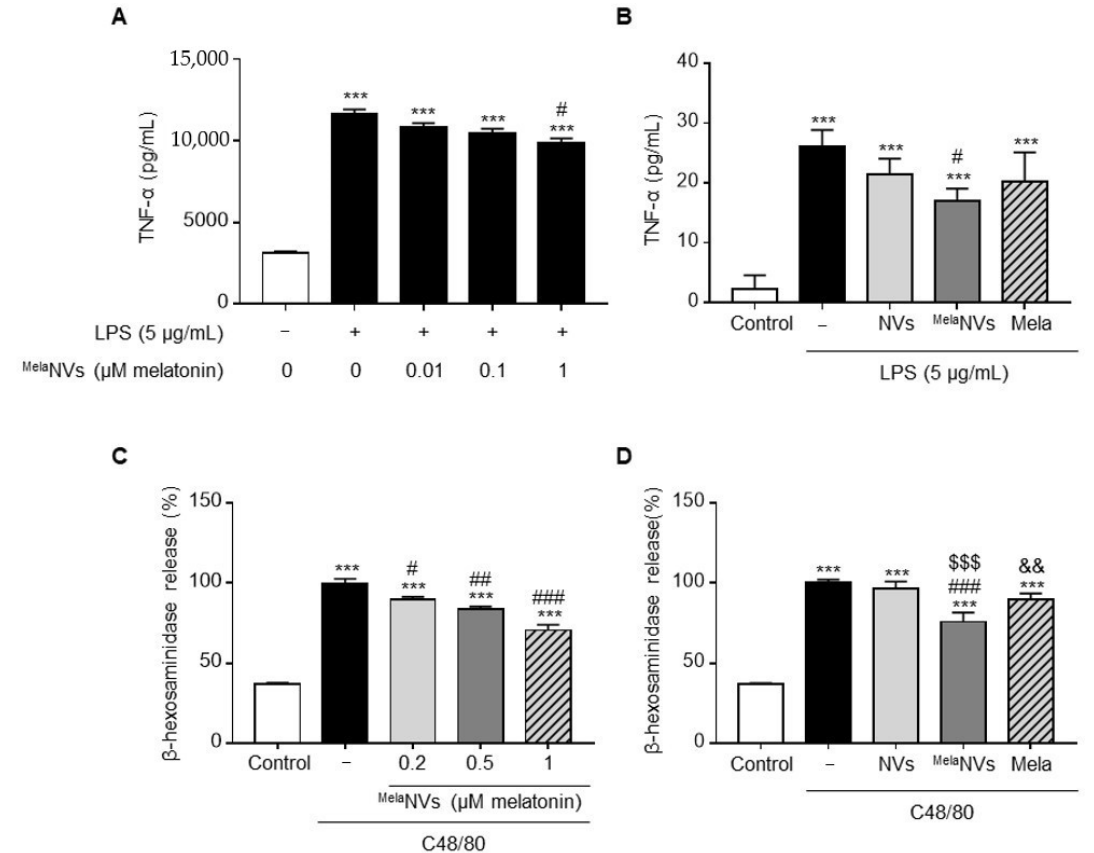
Figure 2. In vitro anti-inflammatory effect of Mela NVs. ( A ) Quantification of TNF- α in conditioned medium of Mela NVs-treated RAW264.7 cells under the LPS condition ( n = 3). *** p < 0.001 versus control. ( B ) Comparison of anti-inflammatory effects of Mela NVs and free melatonin in RAW264.7 cells under the LPS condition ( n = 3). ( C , D ) Quantification of β -hex-osaminidase in conditioned medium of RBL-2H3 cells either treated with NVs, Mela NVs, or free melatonin under C48/80 treatment condition ( n = 3). Data are presented as mean ± SEM. *** p < 0.001 vs. control, # p < 0.05, ## p < 0.01, ### p < 0.001 vs. C48/80 group, $$$ p < 0.001 vs. NVs group, && p < 0.01 vs. Mela NVs group. LPS: lipopolysaccharides; C48/80: compound 48/80; Mela: melatonin.